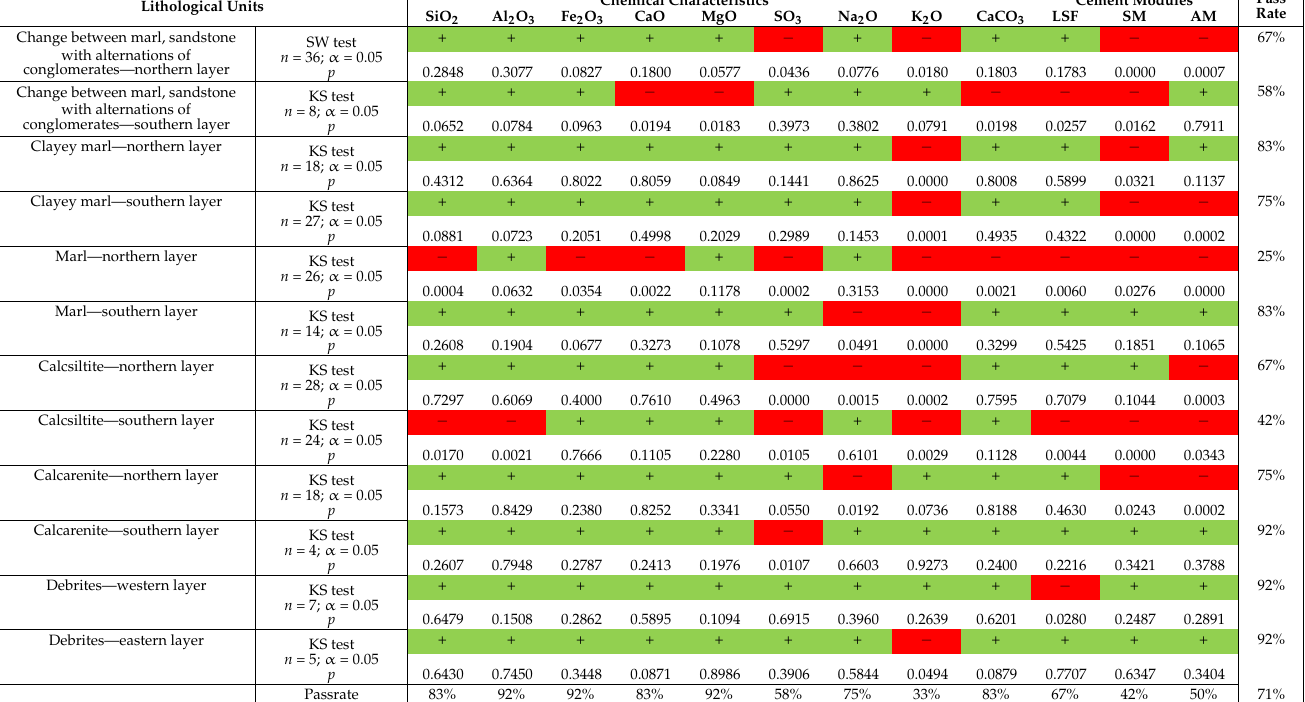
Table 3. Passable levels for the normality tests for oxides and cement modules vs. lithological units. LithologicalUnits ChemicalCharacteristics CementModules Pass RateSiO